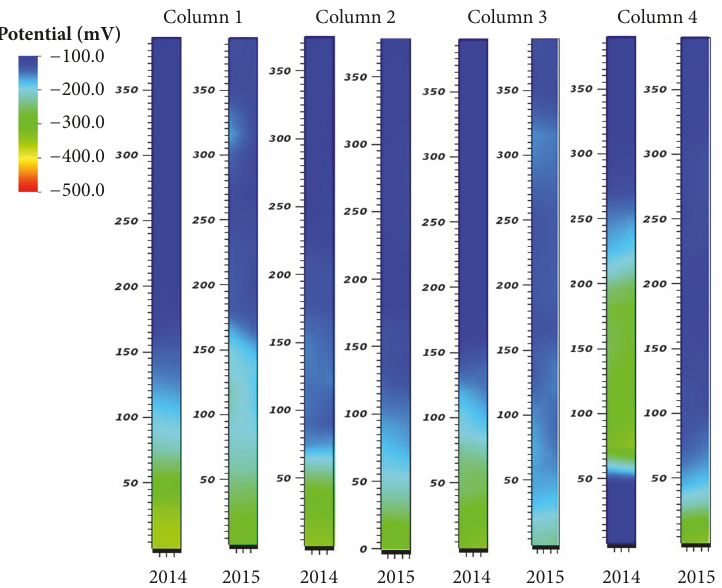
Figure 14: The potential distribution on each column of Object III for 2014 and